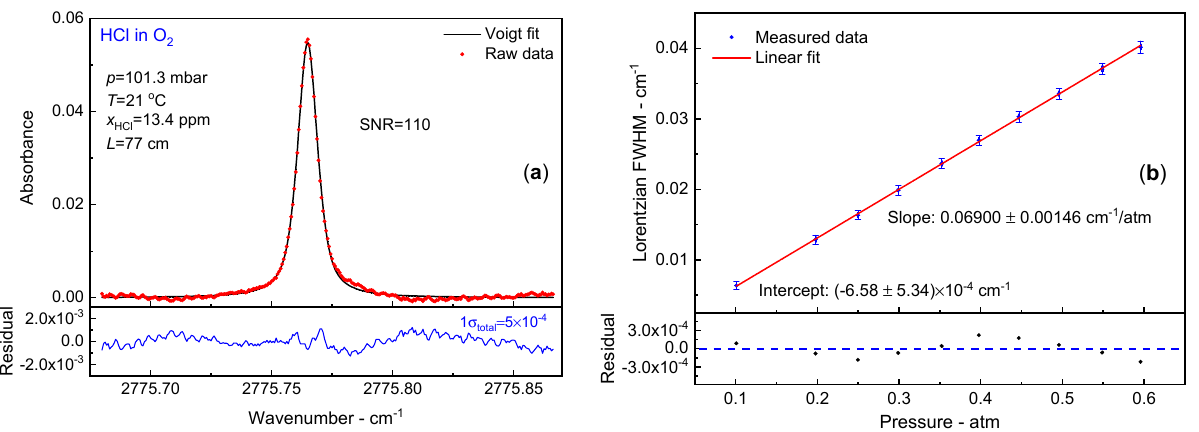
Figure 5. ( a ) Measured O 2 -broadened HCl absorption spectra in O 2 at 101.3 mbar and the fitting residual; ( b ) Measured O 2 induced pressure broadening with a linear fitting model. The residual between fit and data is shown below.